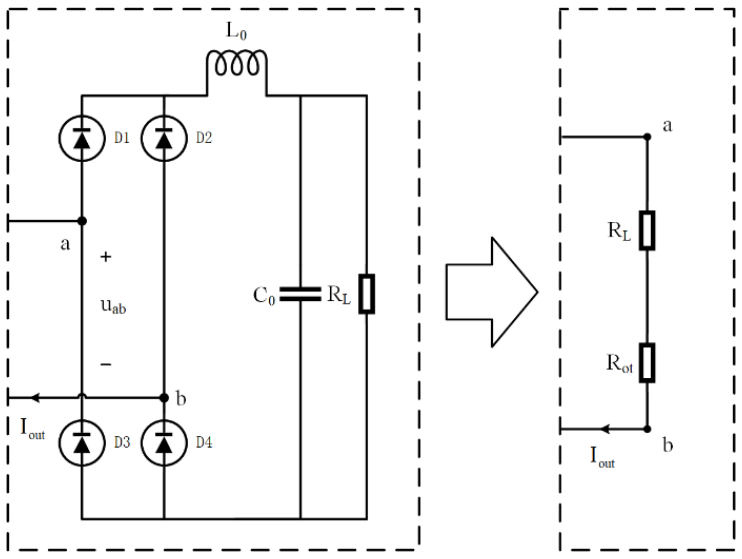
Figure 4. Equivalent circuit, focusing on the rectifier circuit of the secondary side.